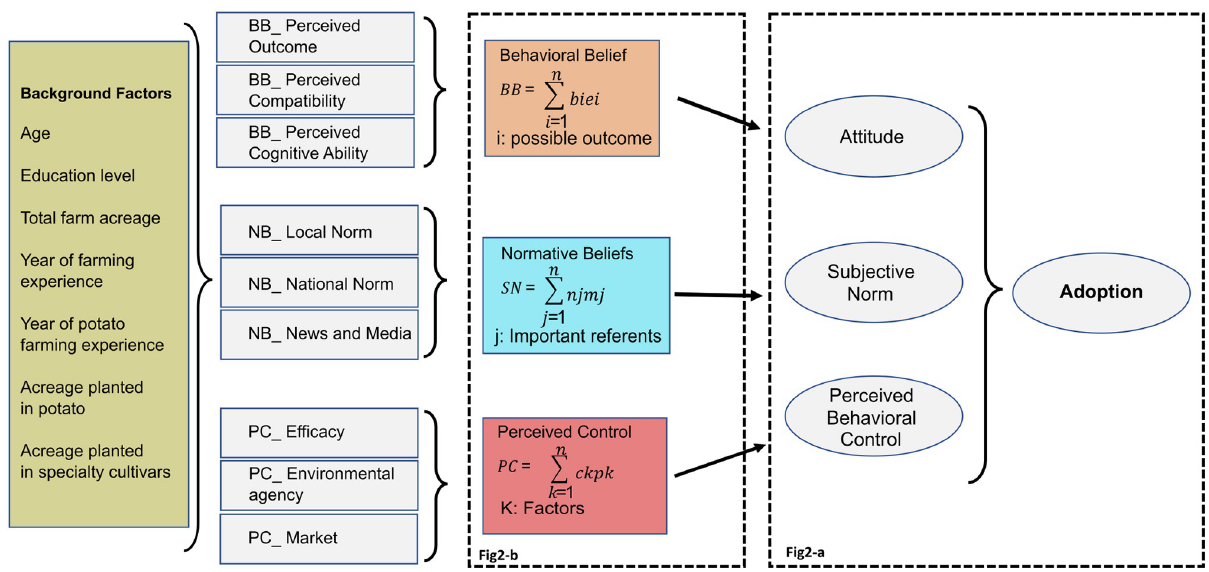
Fig 2. Theoretical framework for adoption of potato SCs. Background factors were collected for analysis of adoption in potato to model behavioral belief (BB), normative belief (NB), and perceived control (PC). (a): Three constructs of the Theory of Planned Behavior (TPB) model, adapted from Ajzen [37]. (b) Adaptation of the models of Borges et al. (2016) and Wauters et al. (2010) shows the aggregative effect of behavioral belief, normative belief, and perceived control on attitude, subjective norm, and perceived behavioral control [50,